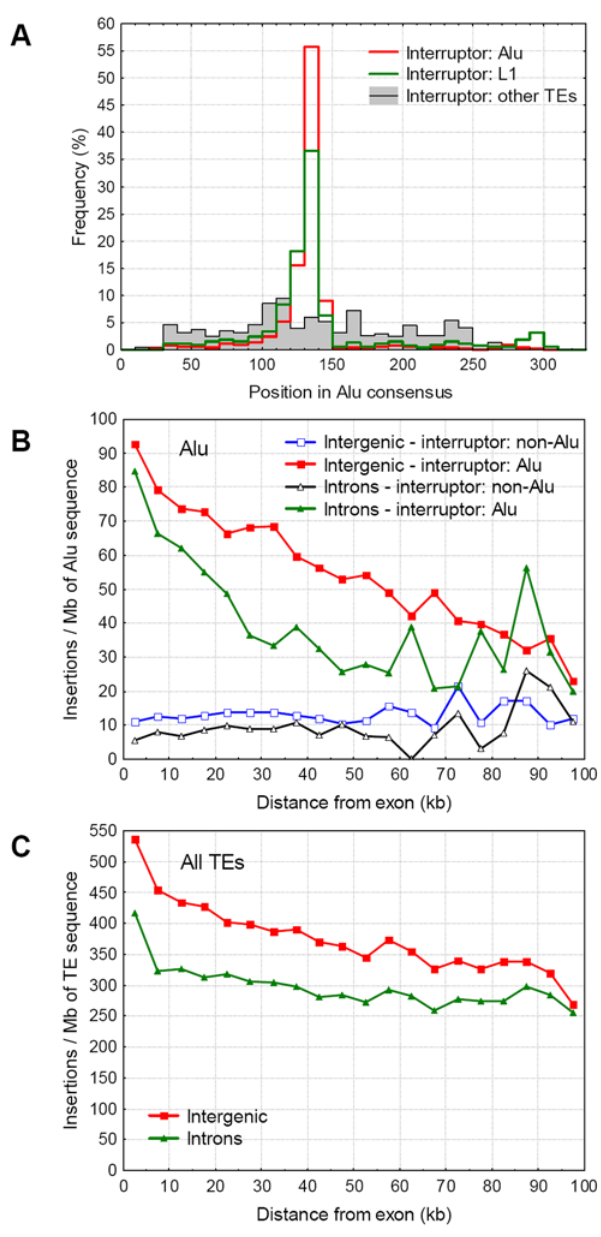
Figure 5. Interruption pattern of Alu repeats on autosomes. A) The distribution of interruptions within the Alu consensus sequence. The vast majority of Alus and L1s insert into the poly-A stretch of the linker region, while the insertions of other repeats are distributed equally across the repeats. B) The distribution of Alu interruptions (standardized with the amount of Alu sequence) in introns and intergenic regions as a function of the distance from the nearest exon or gene, in 5 kb bins. The distribution of Alus interrupted by Alus and other repeats are indicated separately, both for intergenic and intronic repeats. C) The distribution of all TE interruptions in introns and intergenic regions.